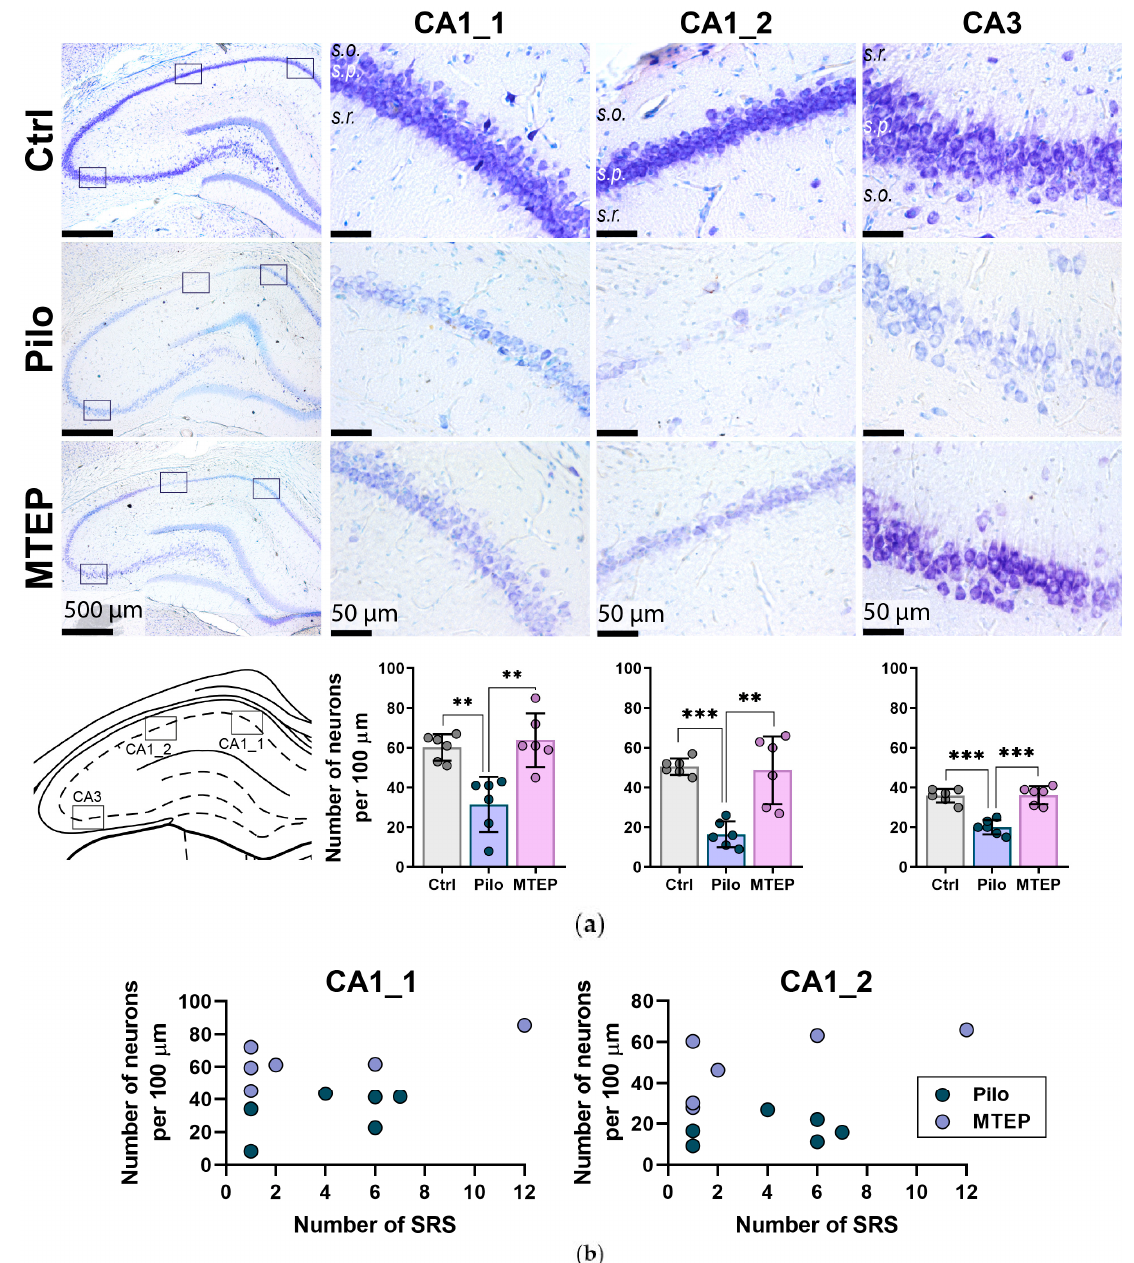
Figure 3. Nissl staining of rats’ hippocampus two months after SE showed the neuroprotective effect of MTEP therapy. ( a ) Three sites in the dorsal hippocampus were selected to analyze the number of neurons in the str. pyramidale (s.p.). CA1_1 is the most common site in the CA1 region for cell counting; CA1_2 is the place in the CA1 area with the most noticeable neurodegeneration. In the CA3 region, we counted neurons in the middle part of this area. The diagrams below show statistical data on the number of neurons per 100 µm length of the cellular layer. The circles show individual values per rat. The columns indicate average values and error bars show standard deviations. One-way ANOVA was performed to determine the neuroprotective effect of MTEP therapy. For CA1_1 region F 2,15 = 13.4, p < 0.001, for CA1_2 F 2,15 = 19.0, p < 0.001, for CA3 F 2,15 = 30.6, p < 0.001. Asterisks indicate significant differences between groups according to Tukey’s post hoc tests: ** p < 0.01, *** p < 0.001. ( b ) Scatter plots illustrate the lack of correlation between the number of seizures and neuronal density in the CA1 area of the hippocampus. The circles show individual values.